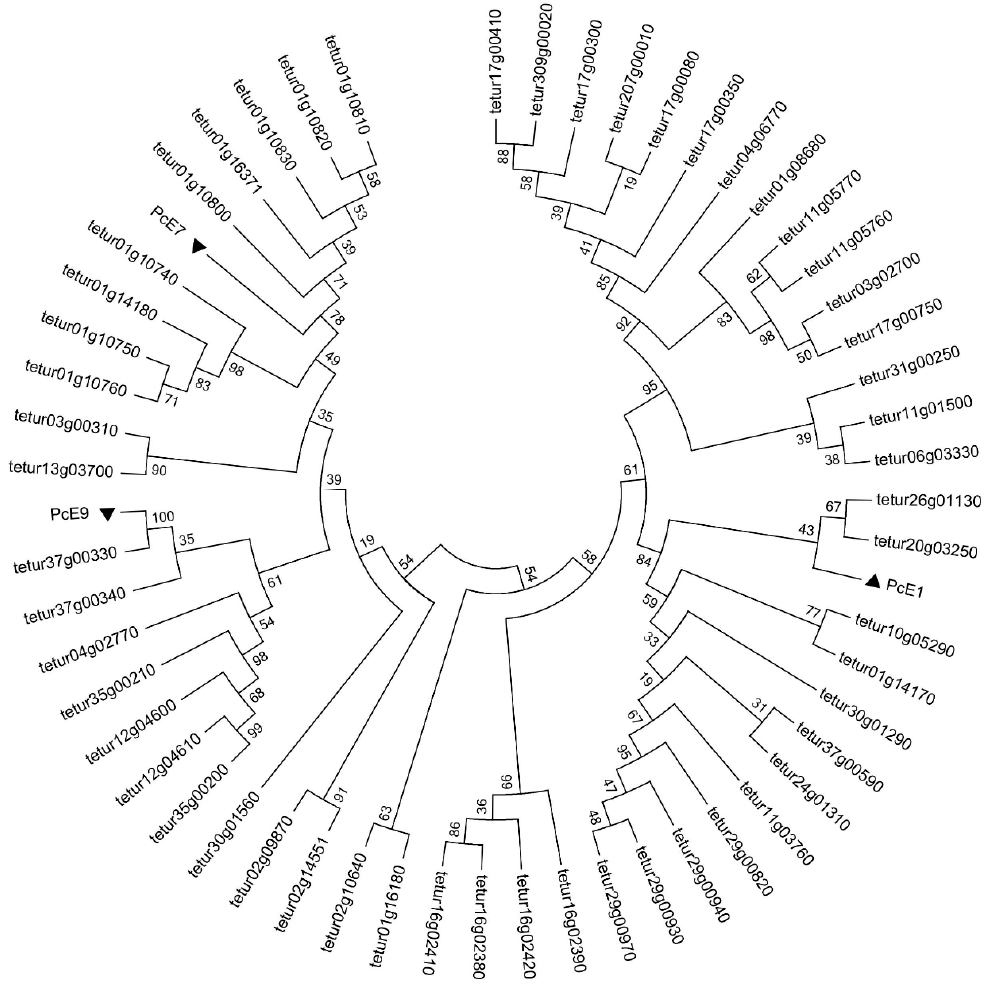
Figure 1. Rooted phylogenetic tree of three CarEs from Panonychus citri with CCE proteins from Tetranychus urticae. All the protein sequences of the T. urticae CCEs were download from http://bioinformatics.psb.ugent.be/orcae/overview/Tetur and PcE1, PcE7 and PcE9 were retrieved from the National Center for Biotechnology Information. All the amino acid sequences were aligned using ClustalW, and a distance neighbor-joining tree was generated using MEGA 5.0. The three CarEs genes examined in this study are marked with triangles.